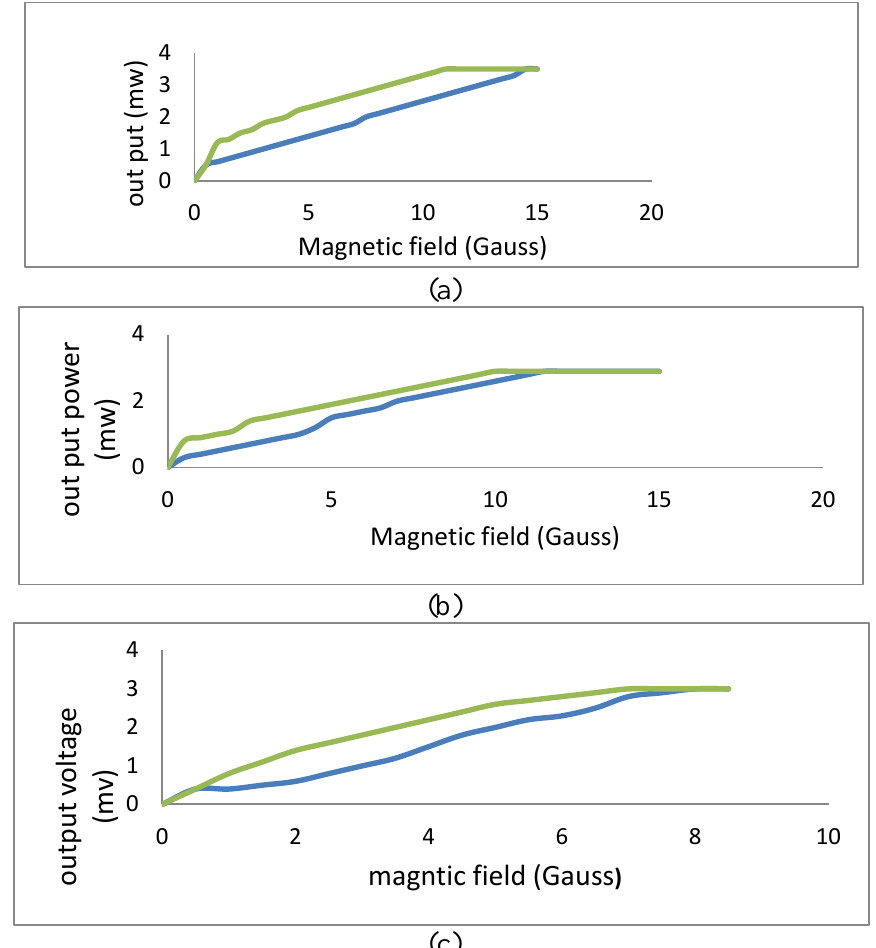
Fig.3: The hysteresis loop of pure ferrofluid magnetic switch with violet, green and the He-Ne